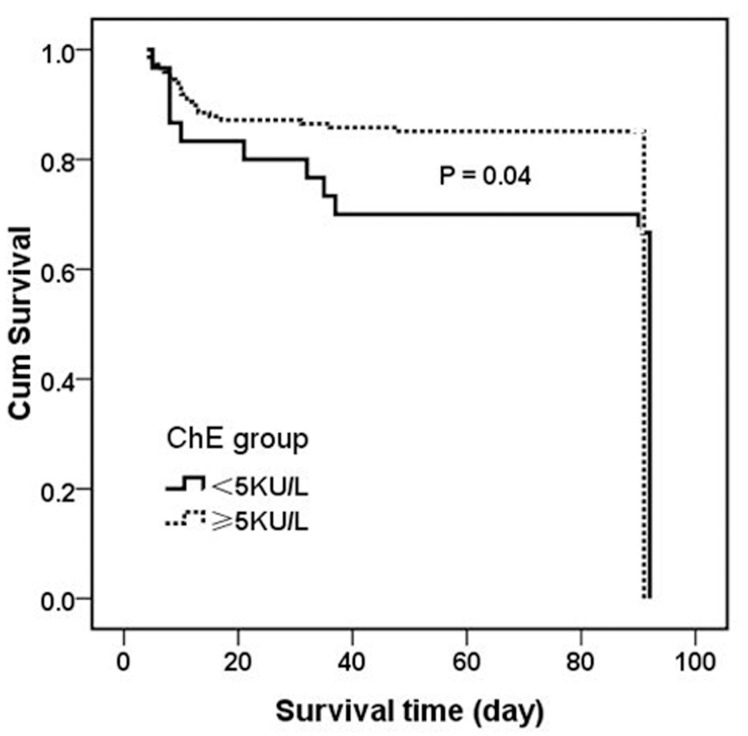
Kaplan-Meier analysis comparing the cumulative percentages of patients who survived according to their serum ChE activities measured 72 hours after TBI.Patients with serum ChE levels >5 kU/L showed a significantly higher chance to survive than patients with lower levels (log-rank test, p = 0.04).